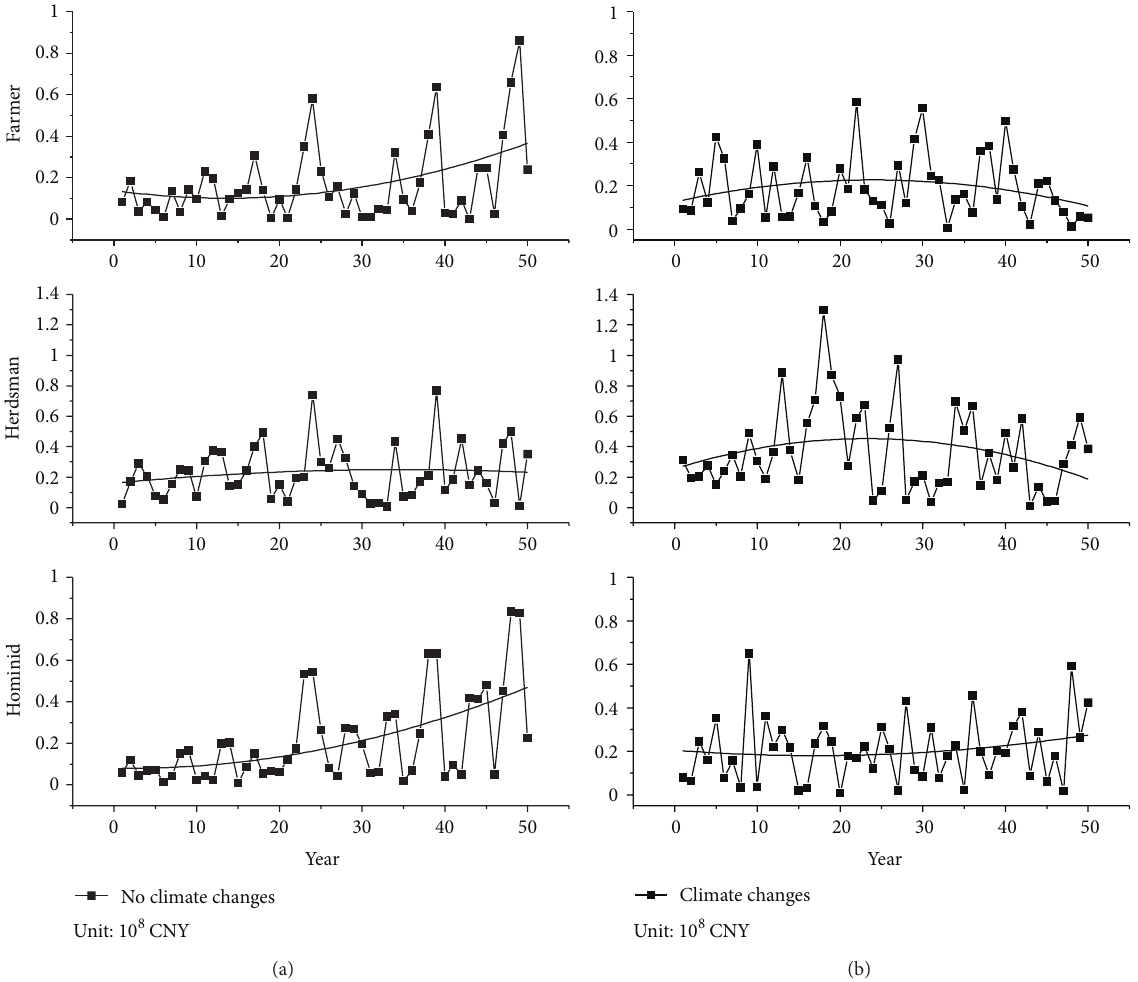
Figure 3: Simulation result of annual income change of agents under the scenario with (b) and without climate changes (a).